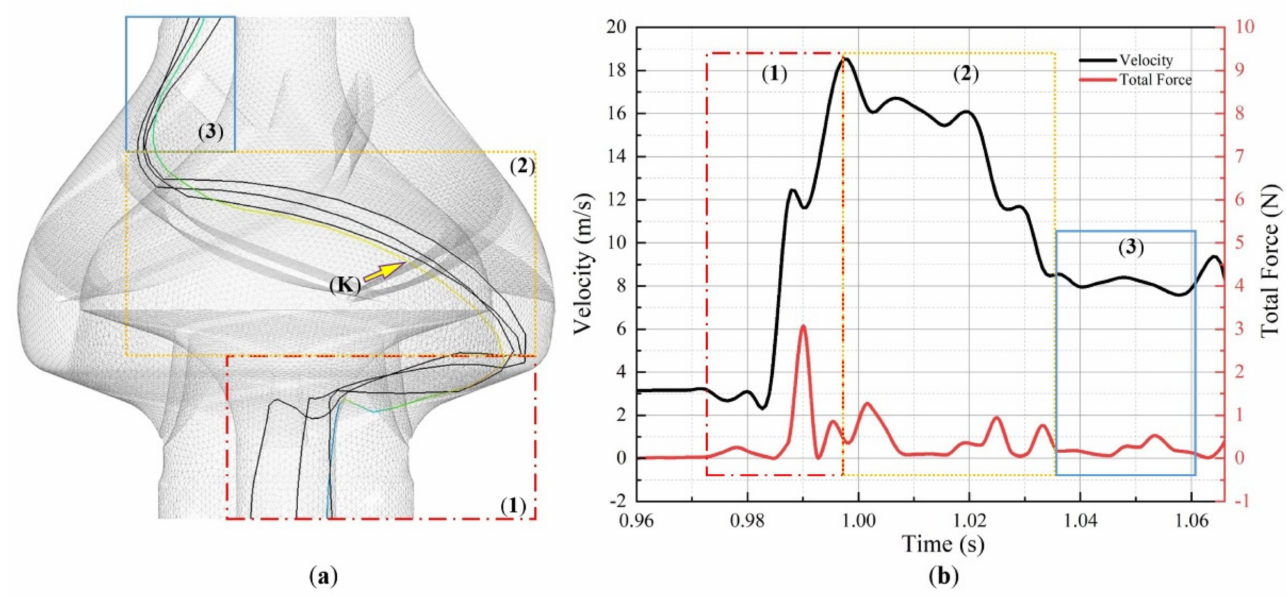
Figure 15. Particle trajectories: ( a ) Trajectories in the diffuser of four typical particles; ( b ) The velocity and total force of particle